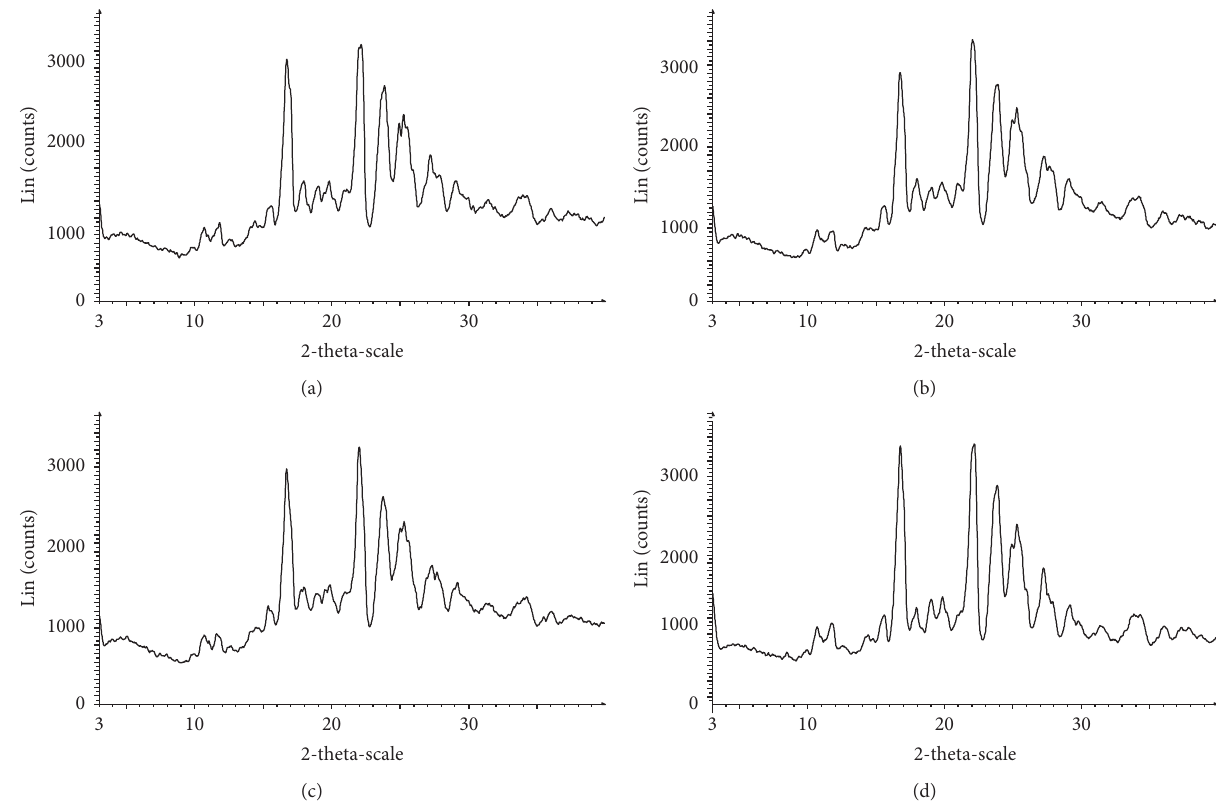
Figure 4: The XRPD pattern of NAR-NCT (a) 60 ° C for 10 days, (b) relative humidity of 90 ± 5% for 10 days, and (c) light of 5000Lx for 10 days, (d) 6 months at room temperature.